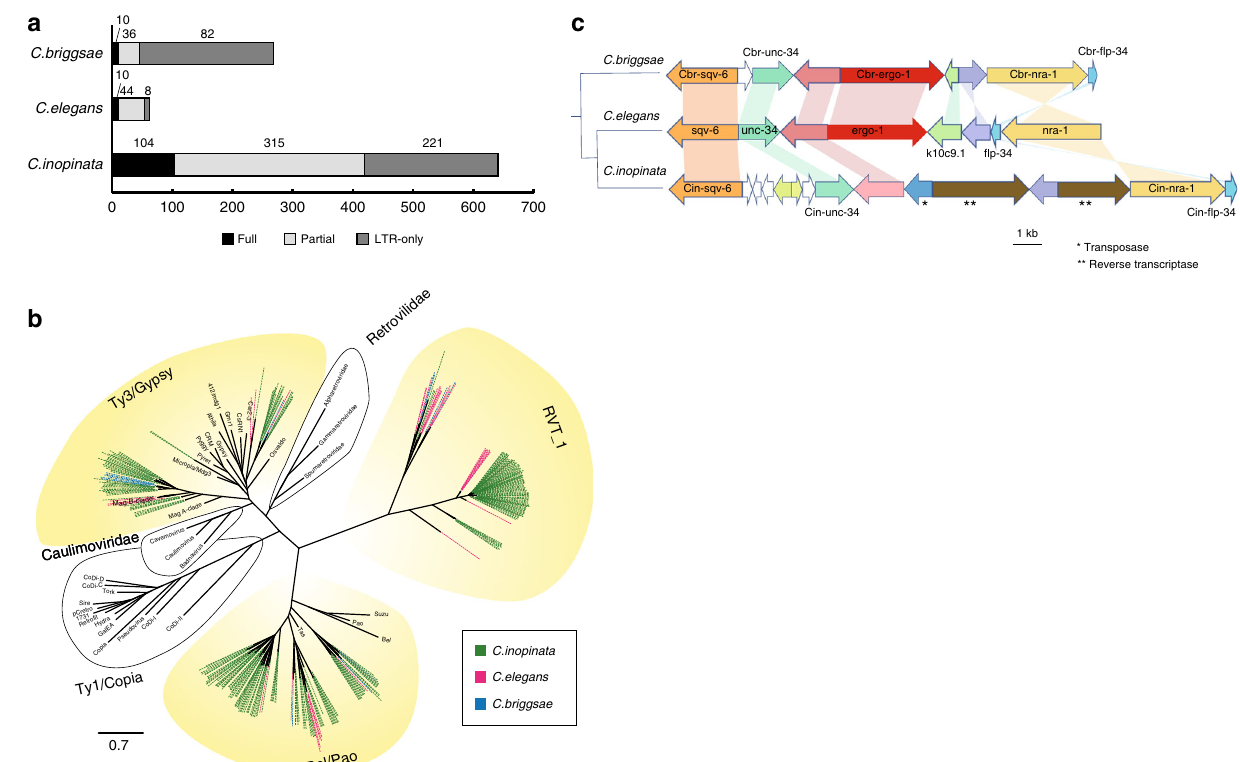
Fig. 5 Transposon expansion and ergo-1 gene loss in C. inopinata . a Number of LTR retro-transposable elements in C. inopinata , C. elegans , and C. briggsae . LTR elements were grouped into ‘ Full ’ with full LTR retrotransposon domain sets (reverse transcriptase; RT, protease, integrase, RNase H), ‘ Partial ’ with at least one of the domains but not full, and ‘ LTR-only ’ having only LTR regions with no protein domains. b Phylogenetic relationships of LTR retrotransposons in the three Caenorhabditis species. RT domains extracted from LTR retro-transposable elements of the three species were aligned by Mafft v7.221 52 with reference sequences obtained from GyDB (Gypsy DataBase) 75 and a maximum-likelihood tree was constructed using RAxML v7.2.8 using the best- fi tting empirical model of amino acid substitution with 1000 bootstrap resampling replicates with the percentage support shown on the nodes. Green, red, and blue lines on the branches represent C. inopinata , C. elegans , and C. briggsae sequences, respectively. The scale bar shows the number of amino acid substitutions per site. c Gene synteny in C. elegans , C. briggsae , and C. inopinata for regions of the genomes corresponding to ergo-1 C. elegans gene. ergo-1 is highlighted in red and orthologous genes are grouped by colour. Genes with no orthology to other genes in the region shown are